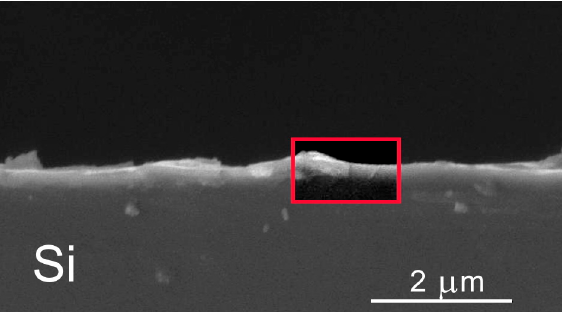
Figure 2. Cross-section SEM image of a pulsed laser P-doped p-Si wafer.